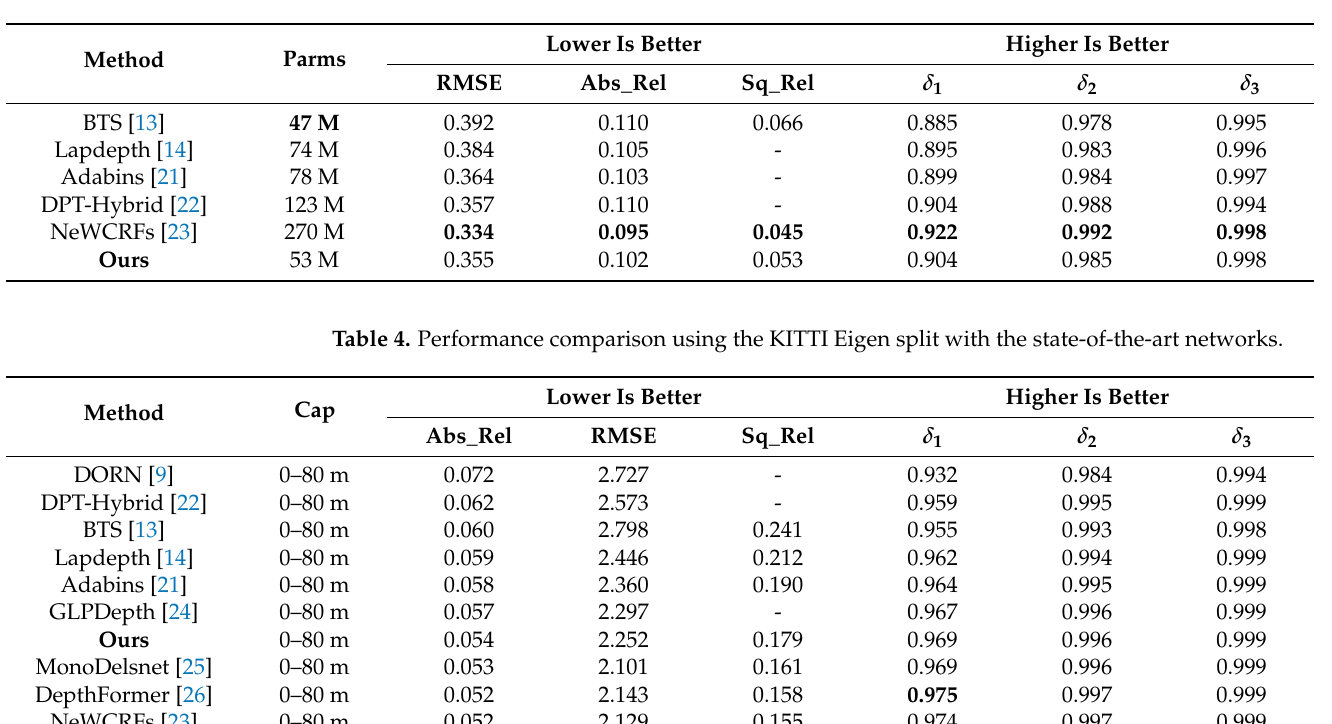
Table 3. Performance comparison results and network parameters using NYU Depth V2 dataset.